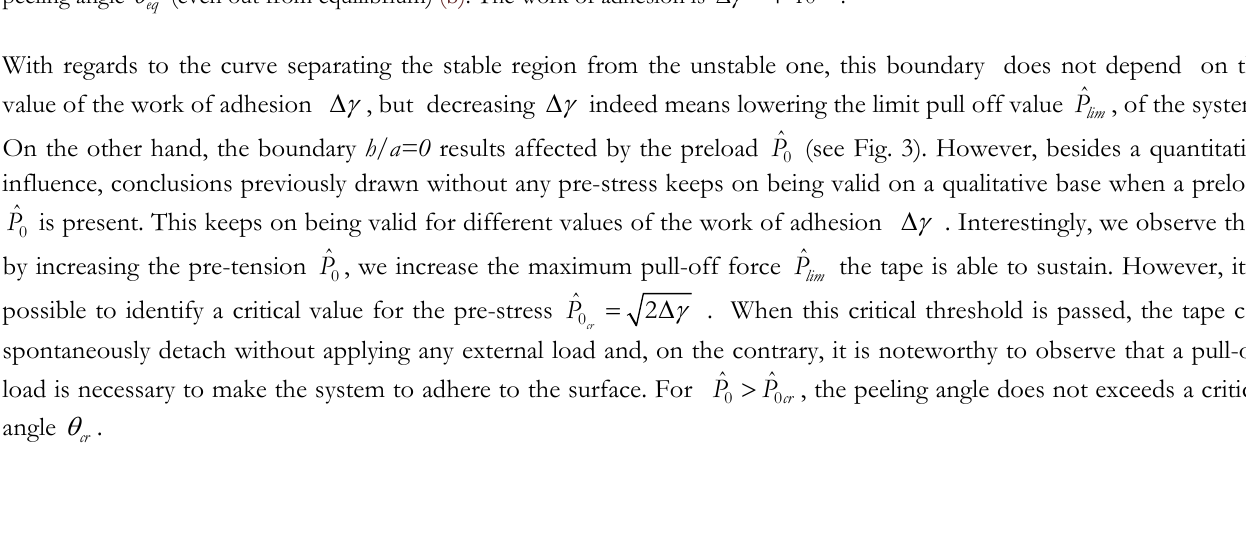
Figure 2: Peeling force ˆ P as a function of the peeling angle in equilibrium conditions  (even out from equilibrium) (b). The work of adhesion is 4 4 10ˆ      peeling angle eq